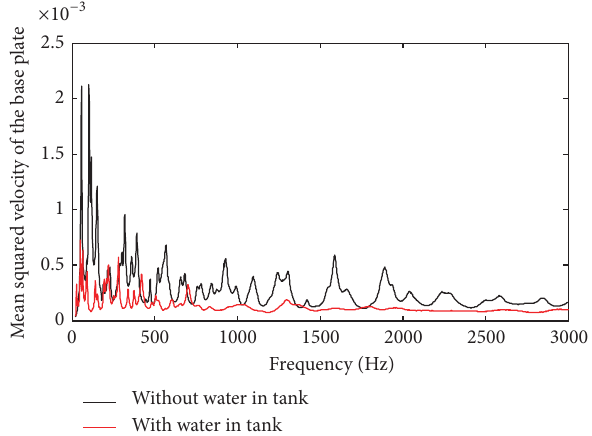
Figure 8: Mean squared velocity of the base plate with and without water in the tank.